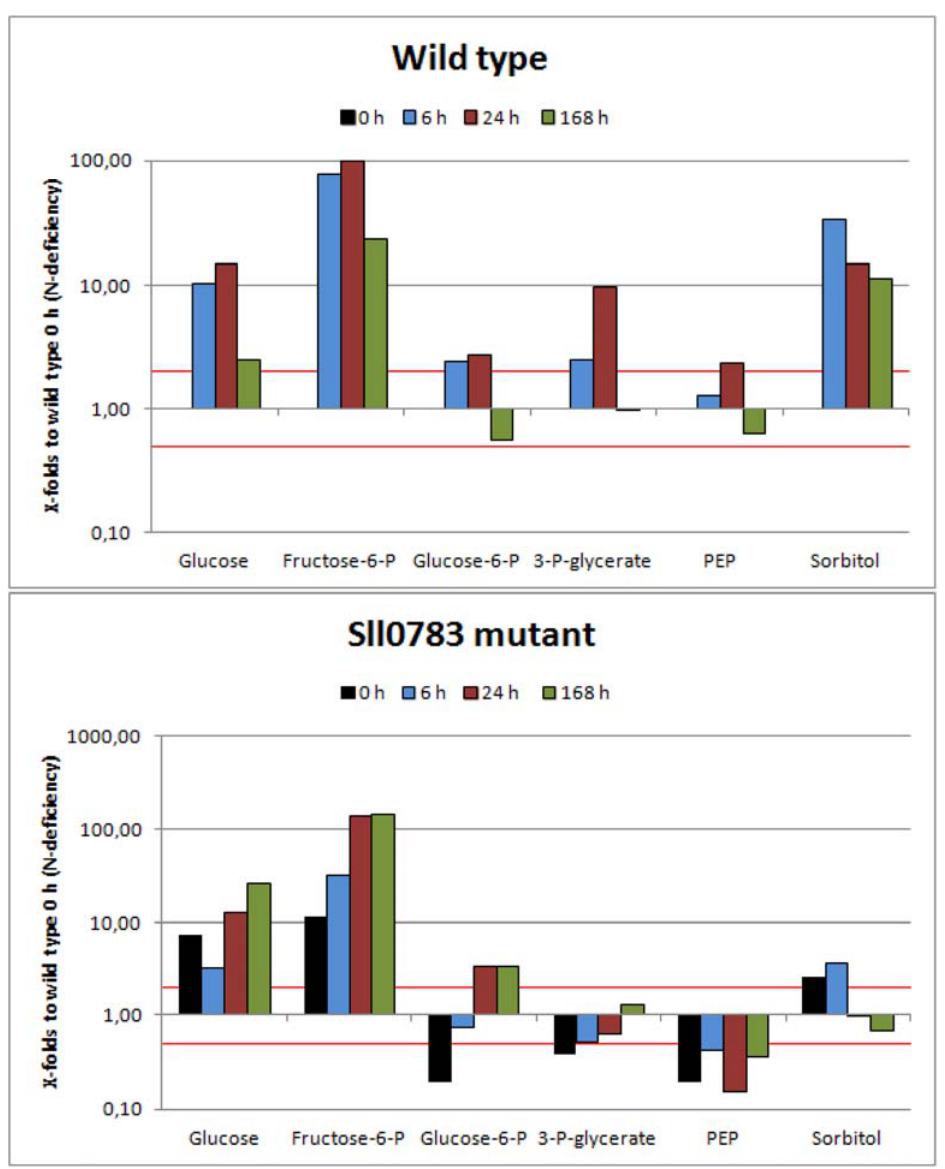
Figure 4. Accumulation of sugar metabolites in wild type and the sll0783 mutant throughout nitrogen starvation. Black bars represent the metabolites levels prior to nitrogen starvation (0 h), cyan bars represent values obtained 6 h, red bars 24 h and green bars 168 h after nitrogen starvation has been induced. All bars represent x-fold changes in metabolite levels compared to the level in wild type at time point 0 h. The red lines mark the values 2 and 0.5. Values above or below these lines represent statistically significant changes of metabolite levels when compared to wild type at time point 0